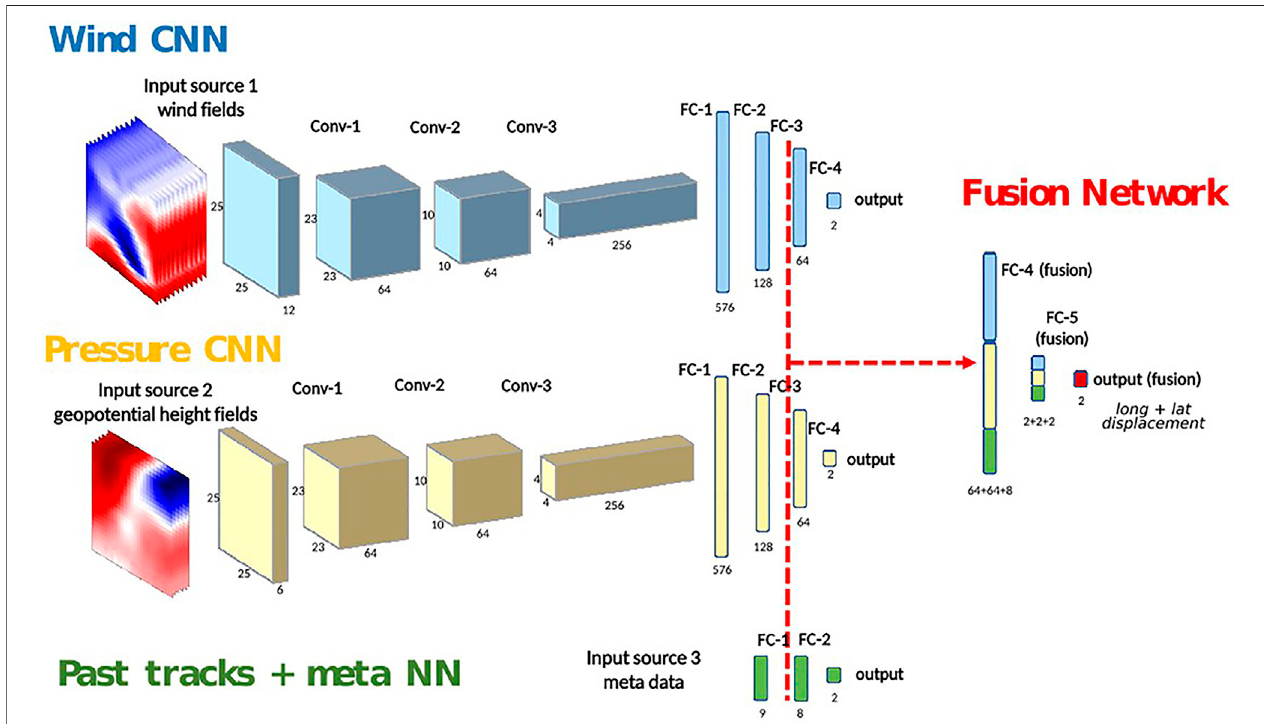
FIGURE 3 | General architecture: a neural network model fusing past trajectory data and reanalysis atmospheric images (Giffard-Roisin et al., 2020).